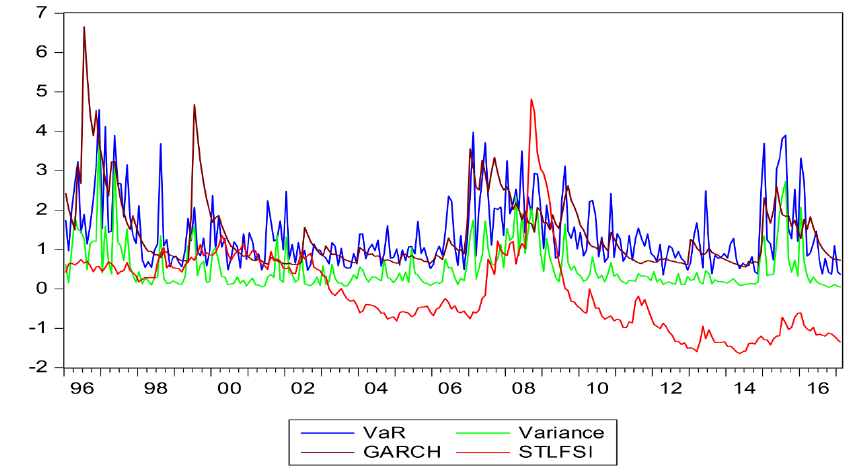
Figure 1. Time series plots of risk measured by VaR, Variance, GARCH and STLFSI.